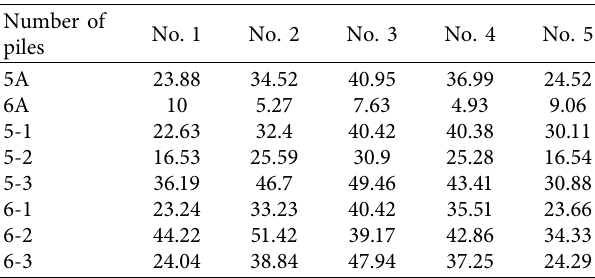
Table 4: Detailed data of fexural deformation (unit: